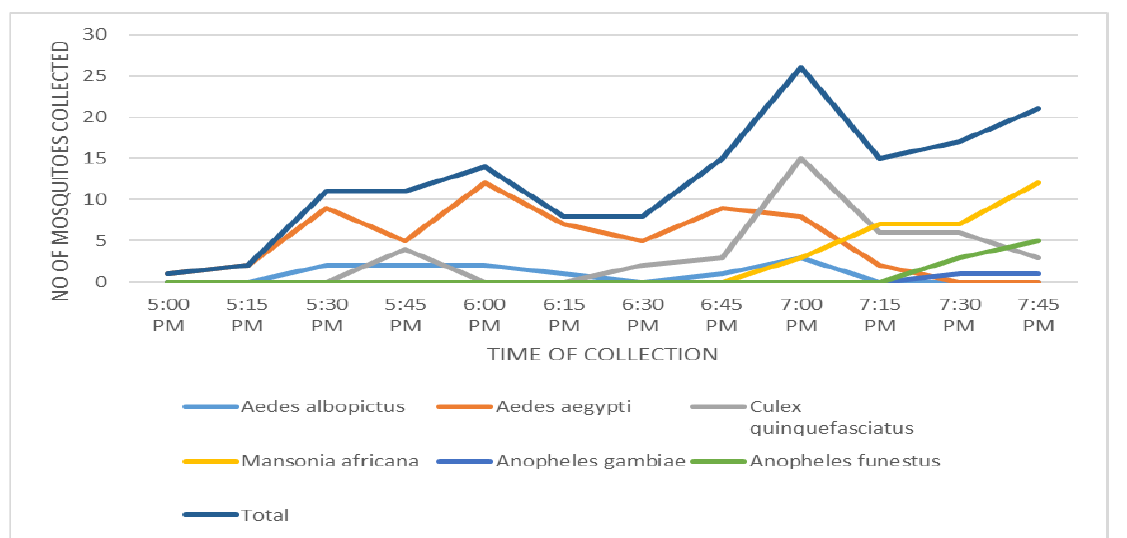
Figure 6. Outdoor-biting mosquito species collected at quarterly hour (15-minutes) intervals